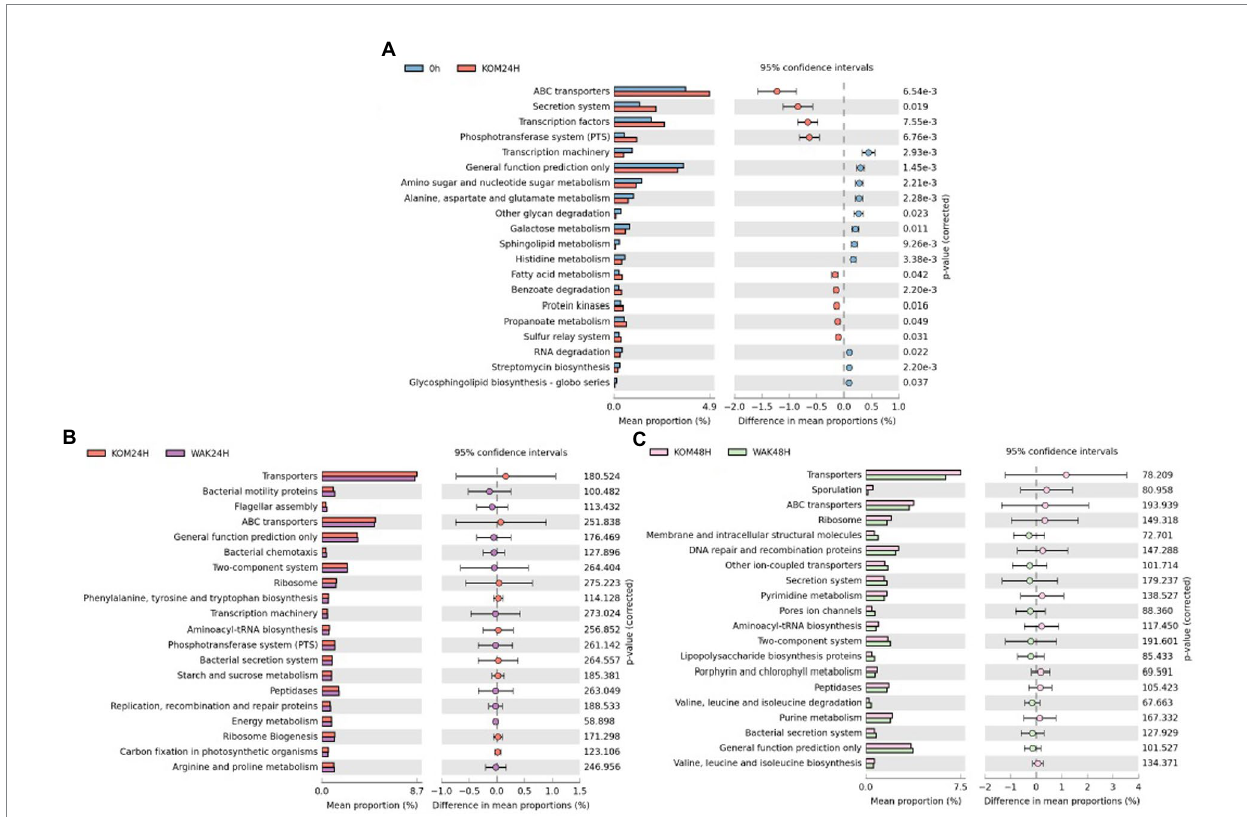
FIGURE 5 Significant differences of the main 20 metabolic pathways between baseline and S. japonica after 24 h fermentation (A) ; Statistical Analysis Functional Profile of the main 20 metabolic pathways for the samples obtained from the in vitro colonic model with S. japonica and U. pinnatifida at 24 h (B) and 48 h (C) . The value of p obtained for all the metabolic functions (only the 20 more representative in graphics) was higher than 0.05, indicating no significant differences between the times of